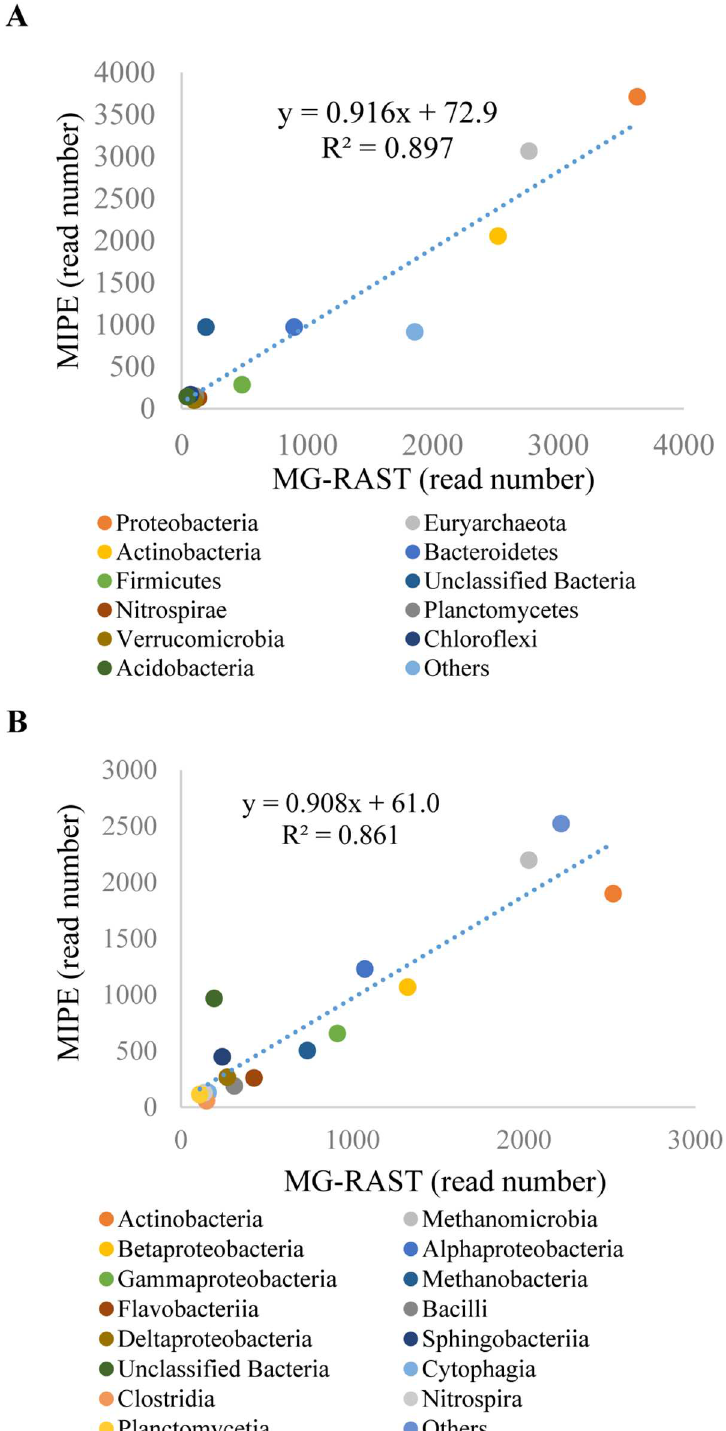
Fig 3. Linear correlation-based comparison of MG-RAST and MIPE. Archaeal and bacterialread numbers used for linear correlationat the (A) phylum and (B) class levels. Taxa whose abundances are greater than 100 reads in either SILVA SSU (v119) or MG-RAST built-inSSU databases are listed separately, and the others are summed into one item.